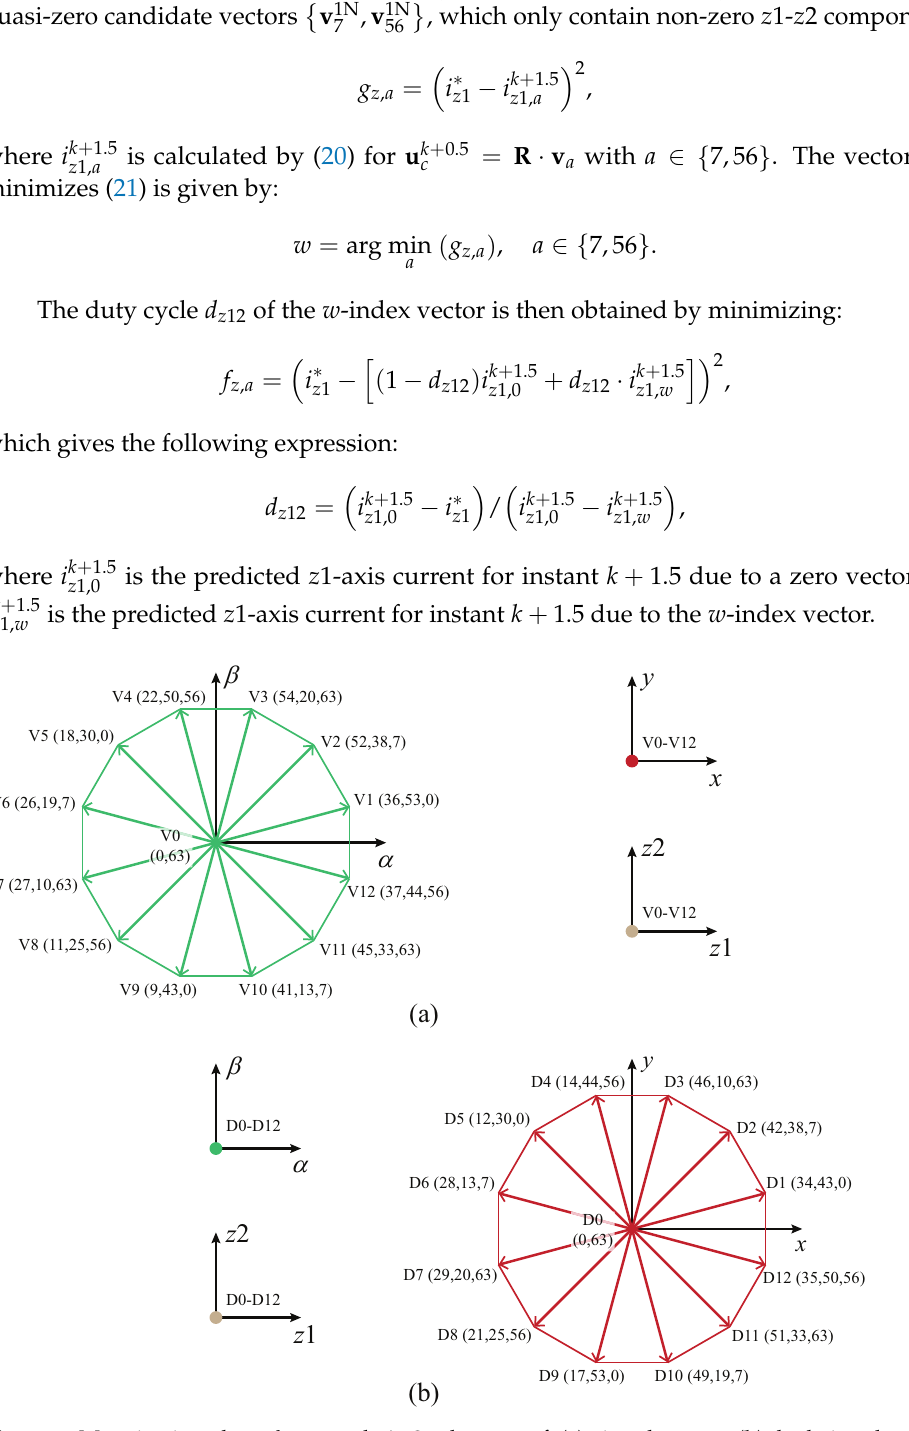
Figure 3. Mapping into the α - β , x - y , and z 1- z 2 subspaces of: ( a ) virtual vectors; ( b ) dual virtual